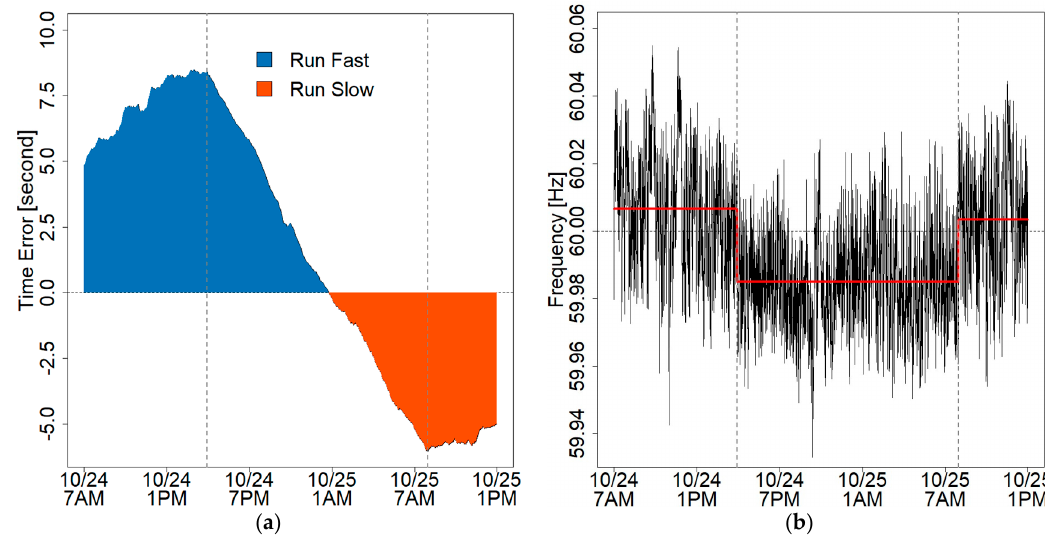
Figure 8. Illustrative example of fast time error correction (TEC) process in Eastern Interconnection (EI) system of North America: ( a ) Time error change from 24 October 2016 07:00 a.m. to 25 October 2016 01:00 p.m.; ( b ) Power system frequency change during the same period of ( a ). The grey vertical line indicates the starting/stopping point of the TEC process. The red solid line indicates the average system frequency before, during and after the TEC process.